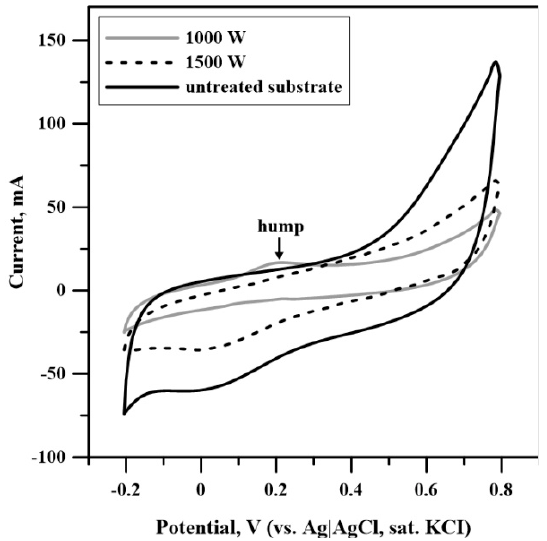
Figure 8. Polarization curves (cyclic voltammograms) of DLC-coated steel samples, scan rate 0.1 V/s; electrolyte phosphate buffer, pH = 7.4, room temperature.